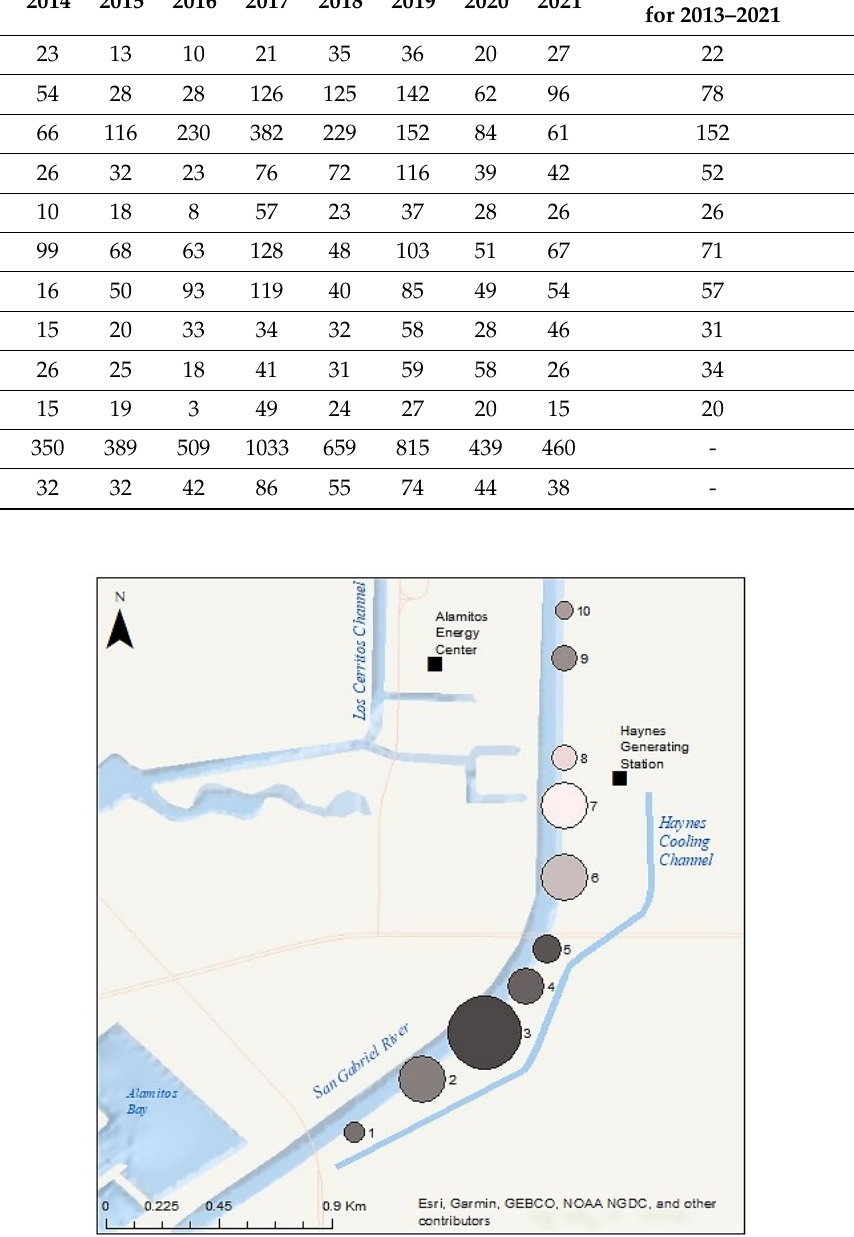
Figure 5. Cumulative Average Number of Turtle Sightings by Station 2013–2021. Larger circles indicate a higher cumulative average number of turtle sightings and vice versa. Averages displayed as circles are from Table 1.